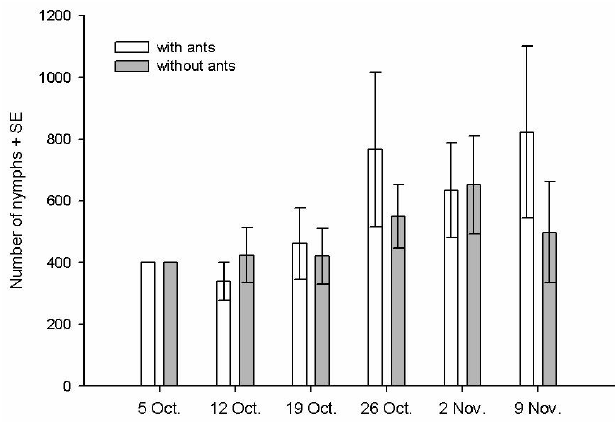
Fig 1. Number of woolly whitefly nymphs per replicate (citrus branch) at different